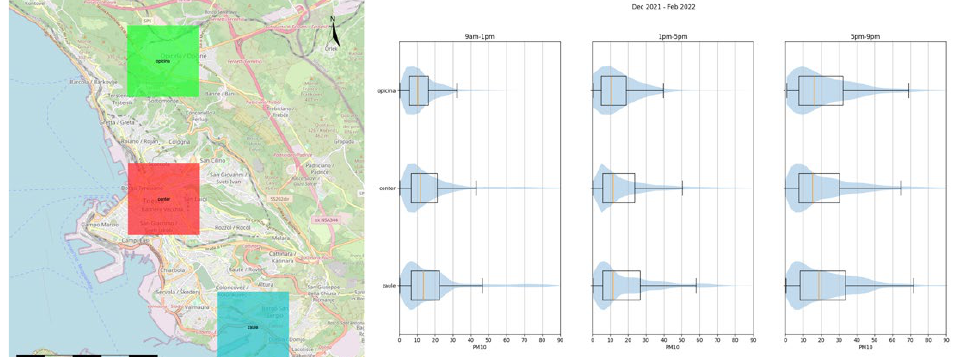
Figure 5. Map of the designated area highlighting the three subzones that have been considered for the analysis ( left ) Matrix of violin plots showing the trends of PM distribution during three time intervals of the day from December to February 2022 ( right ).